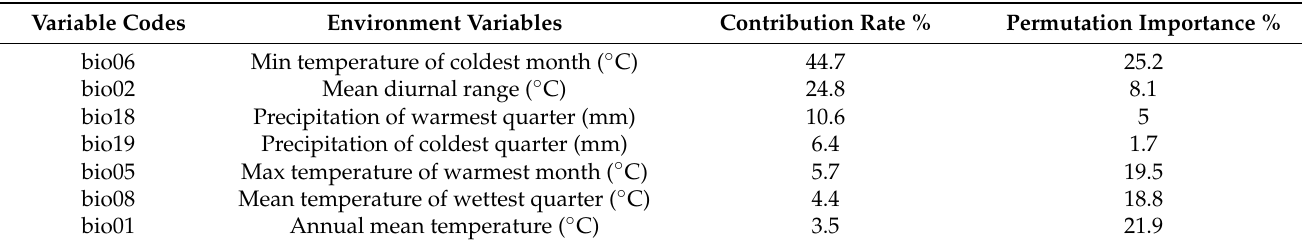
Table 1. Contribution rate and permutation importance of selected environment